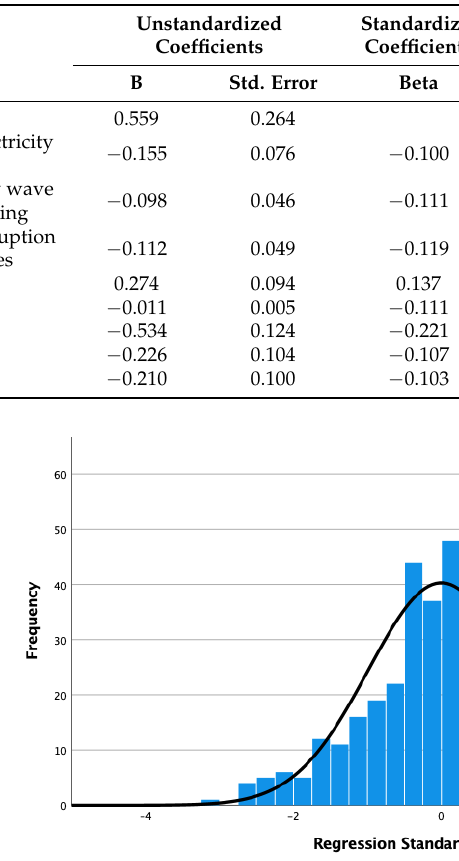
Table 9. Coefficients of the finally selected model.